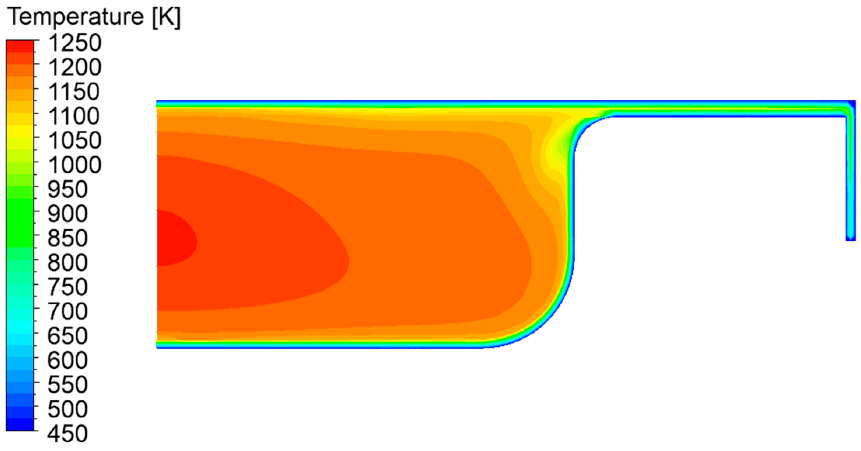
Figure 4. Gas temperature distribution at TDC.